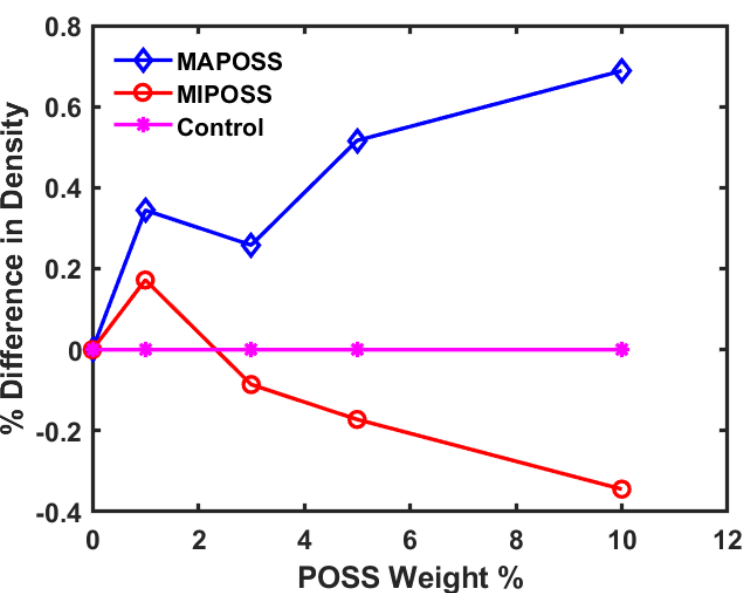
Figure 4. Comparison of density difference as a percentage difference for MAPOSS and MIPOSS composites as a function of POSS composition in weight %.